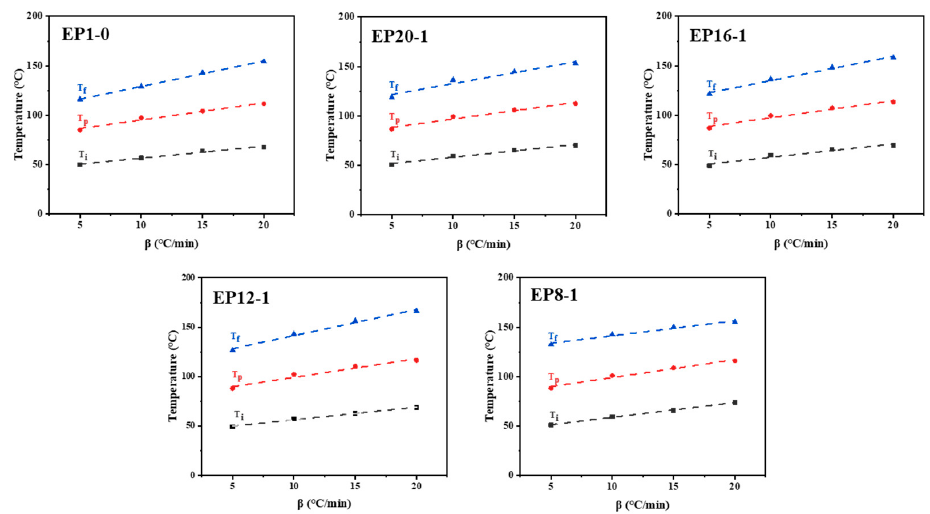
Figure 3. Linear fitting diagram of characteristic temperature-heating rates of the EPx systems. Table 3. Extrapolated characteristic temperatures of the EPx systems.